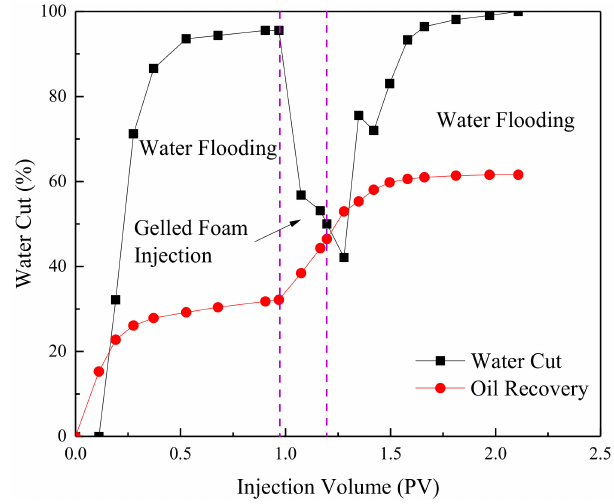
Figure 12. Enhanced oil recovery properties of the gelled foam